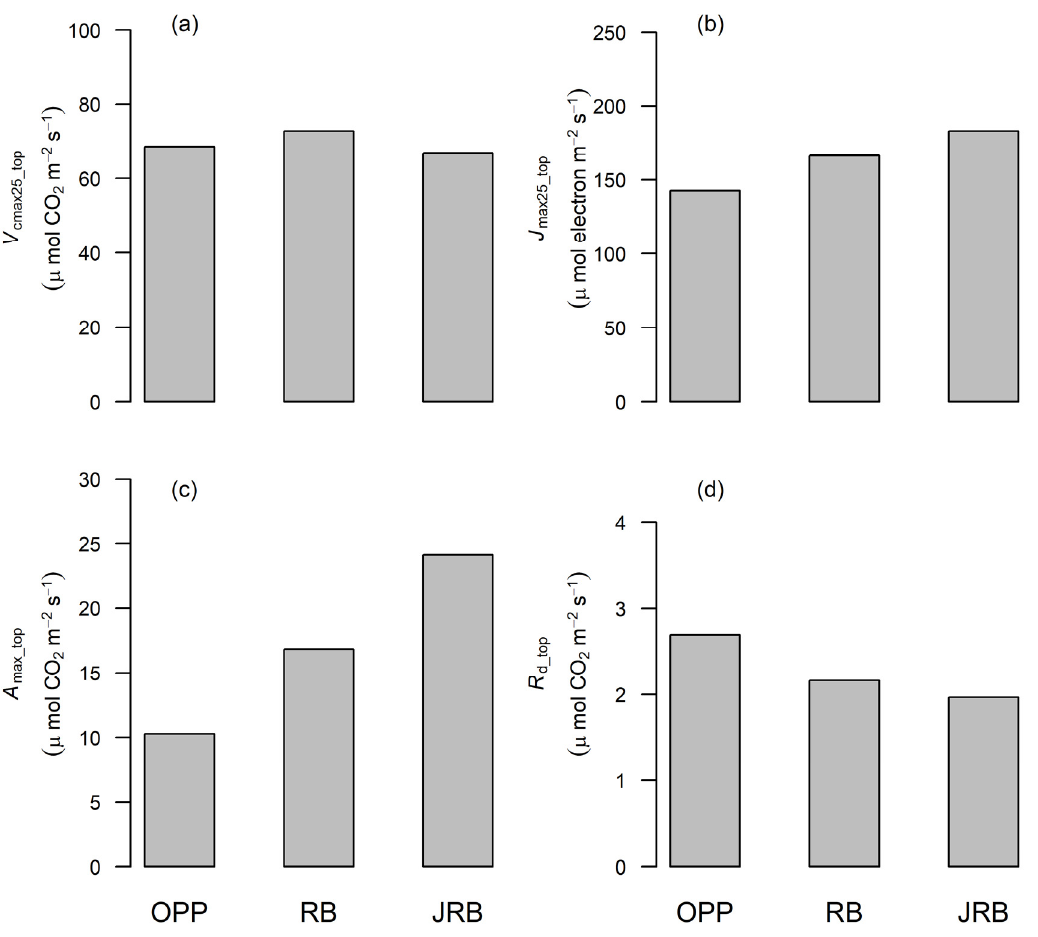
Figure 4. Photosynthetic traits ( V cmax25_top ; a , J max25_top ; b , A max_top ; c , R d_top , d ) estimated at the top of the canopy via the scaling method in OPP, RB and JRP.